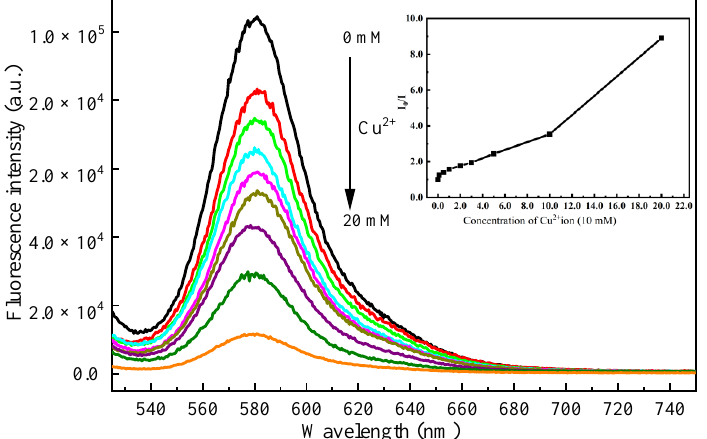
Figure 9. Fluorescence spectra of the test strip for sensing Cu 2+ ion in aqueous solution (0, 0.1, 0.5, 1, 2, 3, 5, 10 and 20 mM, λ ex = 510 nm). Inset: fluorescence quenching efficiency versus the concentration of Cu 2+ ion ( λ em = 585 nm).